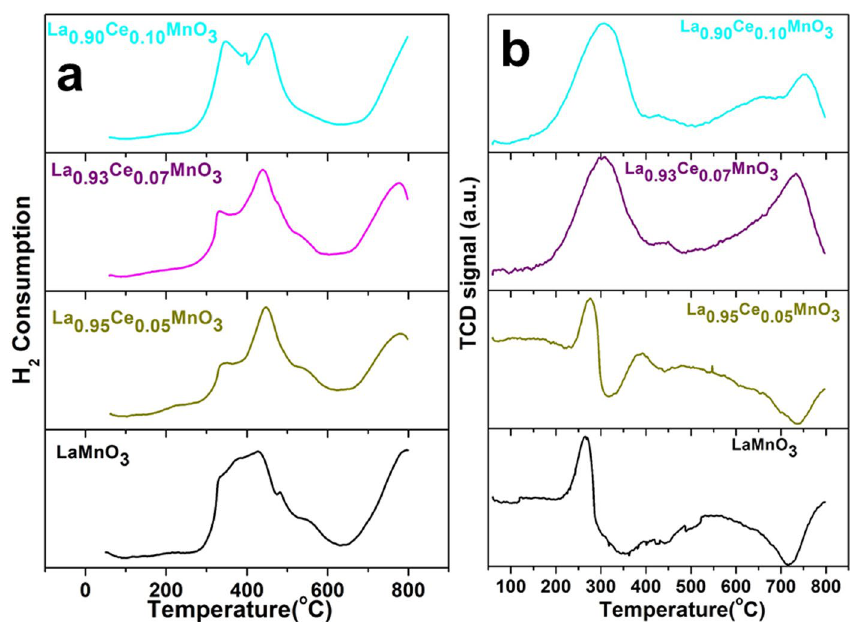
Figure 6. ( a) Temperature program reduction and ( b ) Temperature program oxidation spectra of LaMnO 3 ,